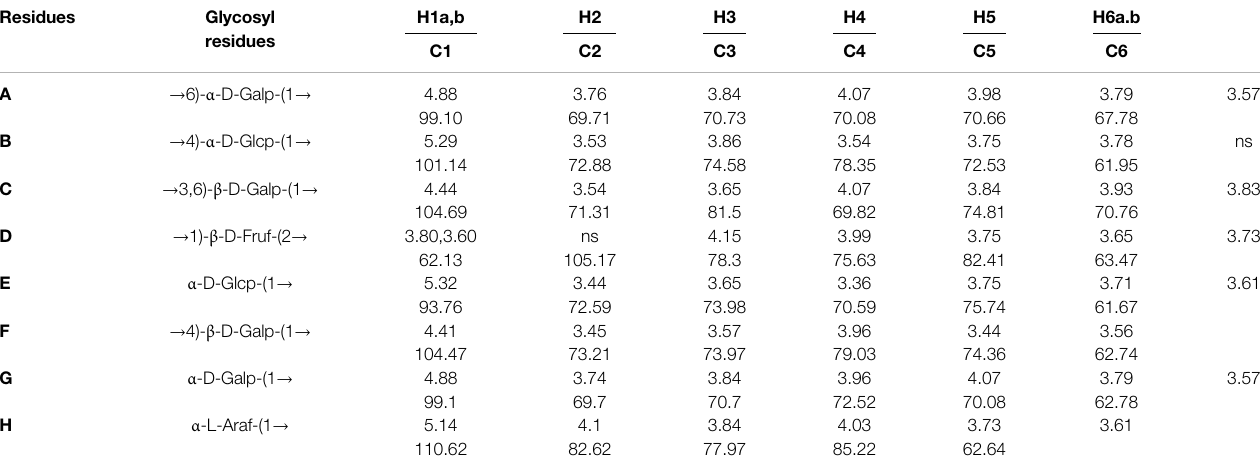
TABLE 2 | 1 H NMR and 13 C NMR spectral assignments for